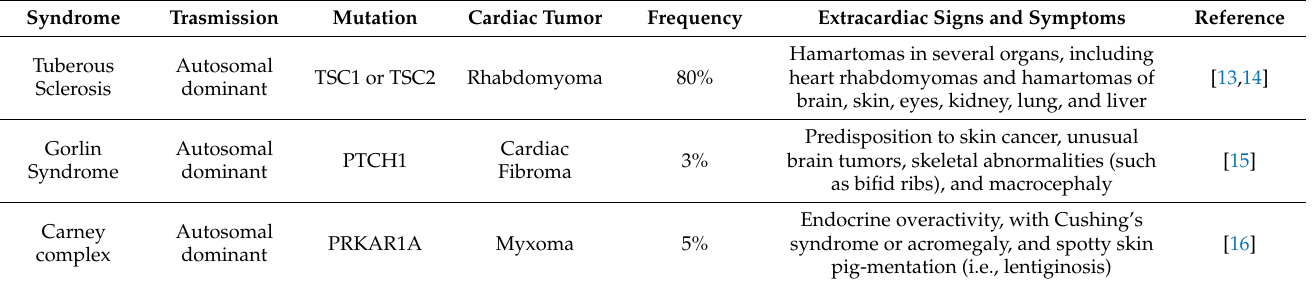
Table 1. Main genetic syndromes associated to cardiac